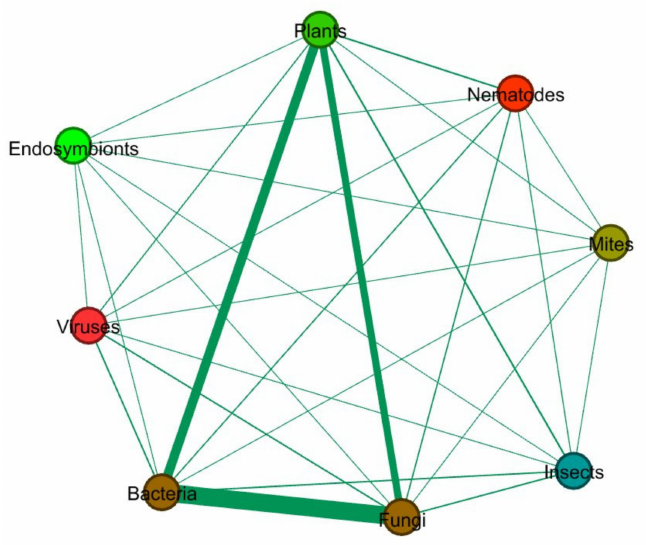
Figure 1. Number of publications with the keyword “biodiversity” indicated, for each node pair, by the edge thickness (data retrieved from PubMed, search period: 1947–2020; network produced with Gephi, https://gephi.org (accessed on 13 December 2020)).